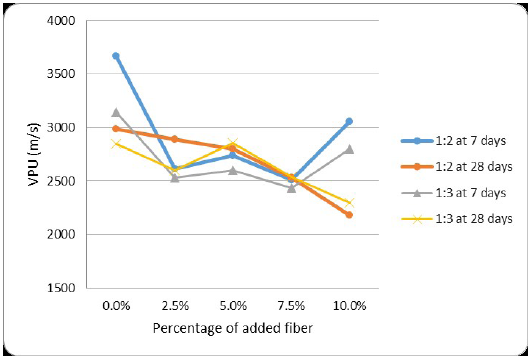
Figure 4. Average of the ultrasonic pulse propagation speed.